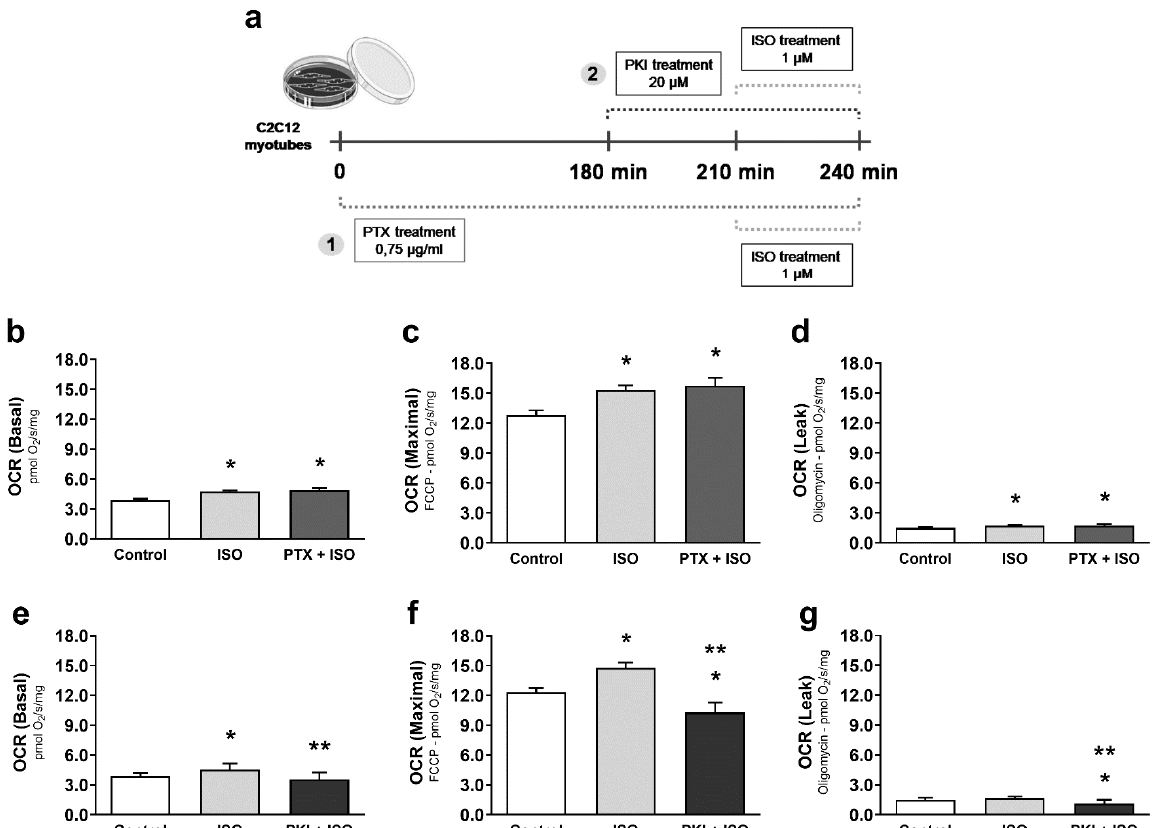
Figure 8. Increased mitochondrial function after activation of β 2 -ARs is dependent on downstream G α s -PKA signaling. Experimental design for pharmacological treatments in C2C12 myotubes ( a ), basal mitochondrial OCR (oxygen consumption ratio) ( b ), maximal mitochondrial OCR induced by FCCP ( c ), and ATP-independent OCR measured in the presence of oligomycin ( d ) in C2C12 myotubes acutely exposed to the non-selective β -AR agonist isoproterenol (ISO—1 µ M for 30 min), with or without G α i protein blockade with pertussis toxin (PTX—0.75 µ g/mL, 3 h prior to ISO treatment). Basal mitochondrial OCR ( e ), maximal mitochondrial OCR induced by FCCP ( f ), and ATP-independent OCR measured in the presence of oligomycin ( g ) in C2C12 myotubes acutely exposed to the non-selective β -AR agonist isoproterenol (ISO—1 µ M for 30 min), and/or under PKA blockade with PKI (20 µ M, 30 min prior to ISO treatment). Data are presented as mean ± SE. * p < 0.05 vs. control and ** p < 0.05 vs. ISO. n = 9/group.